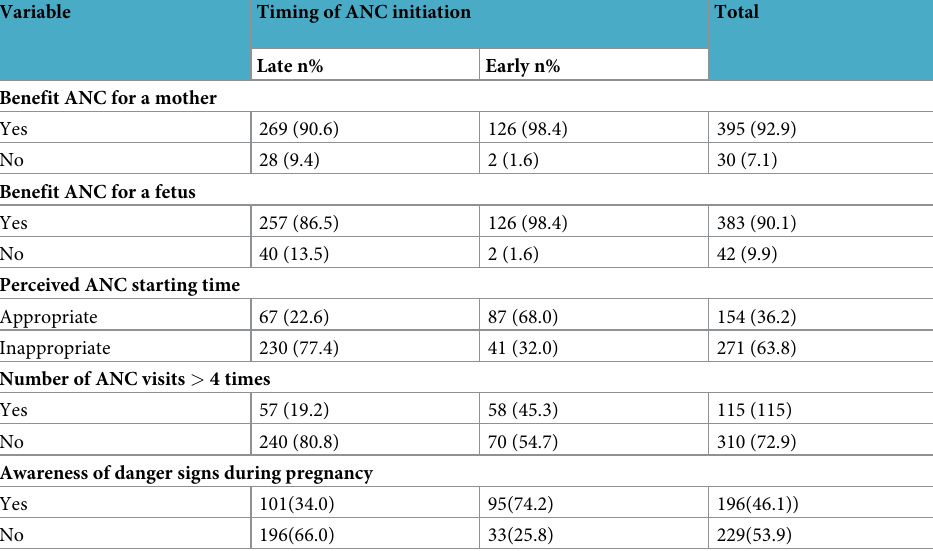
Table 4. Knowledge and perception of participants on the timing of ANC utilization visit health institution for ANC service in Mizan-Aman town, southwest Ethiopia 2021. Variable Timing of ANC initiation Total Late n% Early n% Benefit ANC for a mother